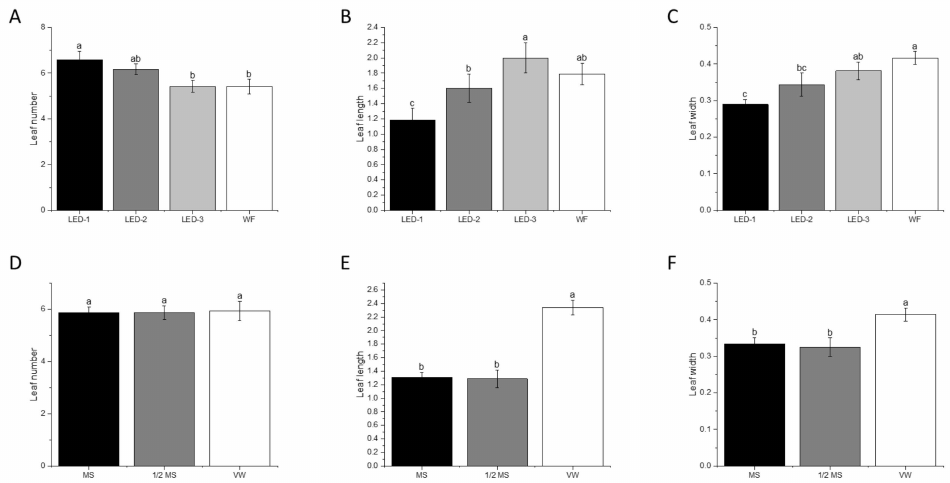
Figure 3. Effects of light sources and culture media on leaf number ( A , D ), leaf length (cm) ( B , E ), and leaf width (cm) ( C , F ) on B. nodosa in vitro plantlets after 60 days of culture establishment. LED- 1: Light-emitting diode (LED) light with 1575 ± 50 µ mol m − 2 s − 1 Photosynthetic Photon Flux Density (PPFD); LED-2: LED light with 1015 ± 50 µ mol m − 2 s − 1 PPFD; LED-3: LED light with 80 ± 5 µ mol m − 2 s − 1 PPFD; and WF: white fluorescent light with 50 ± 5 µ mol m − 2 s − 1 PPFD. MS: MS basal medium supplemented with 30 g L − 1 sucrose and 7 g L − 1 agar; 1 / 2 MS: half-strength MS basal medium supplemented with 15 g L − 1 sucrose and 7 g L − 1 ; VW: VW basal medium supplemented with 10% coconut water, 20 g L − 1 sucrose and 7 g L − 1 . Bars indicate mean ± SE. Different letters indicate significant differences by Tukey’s test at p ≤